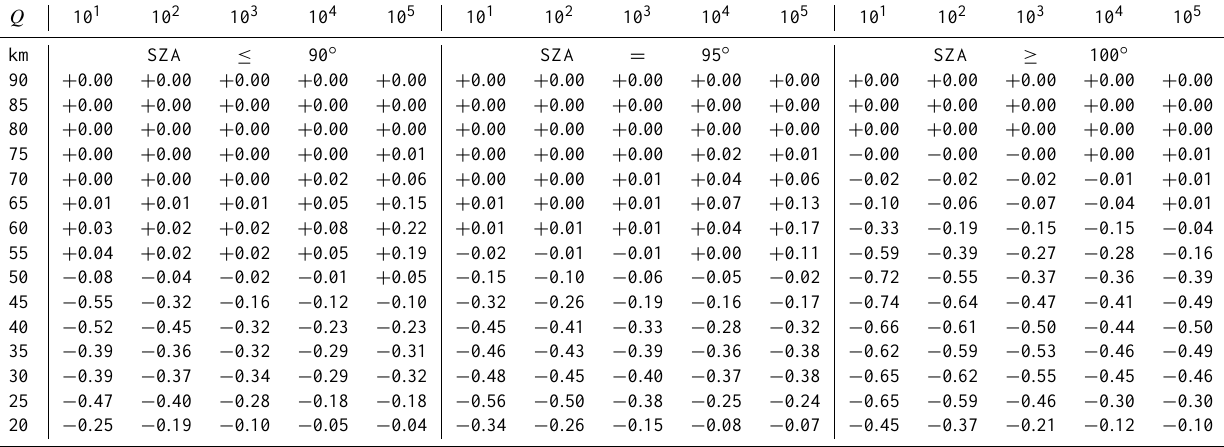
/Q for October SH. 2